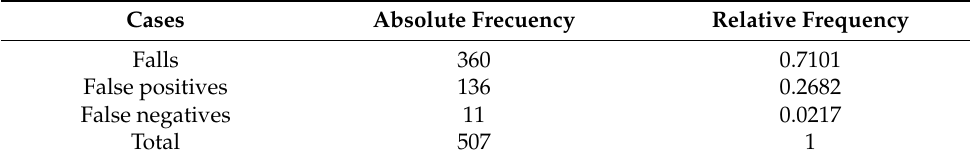
Table 3. Frequency table of the results obtained from the observed System.